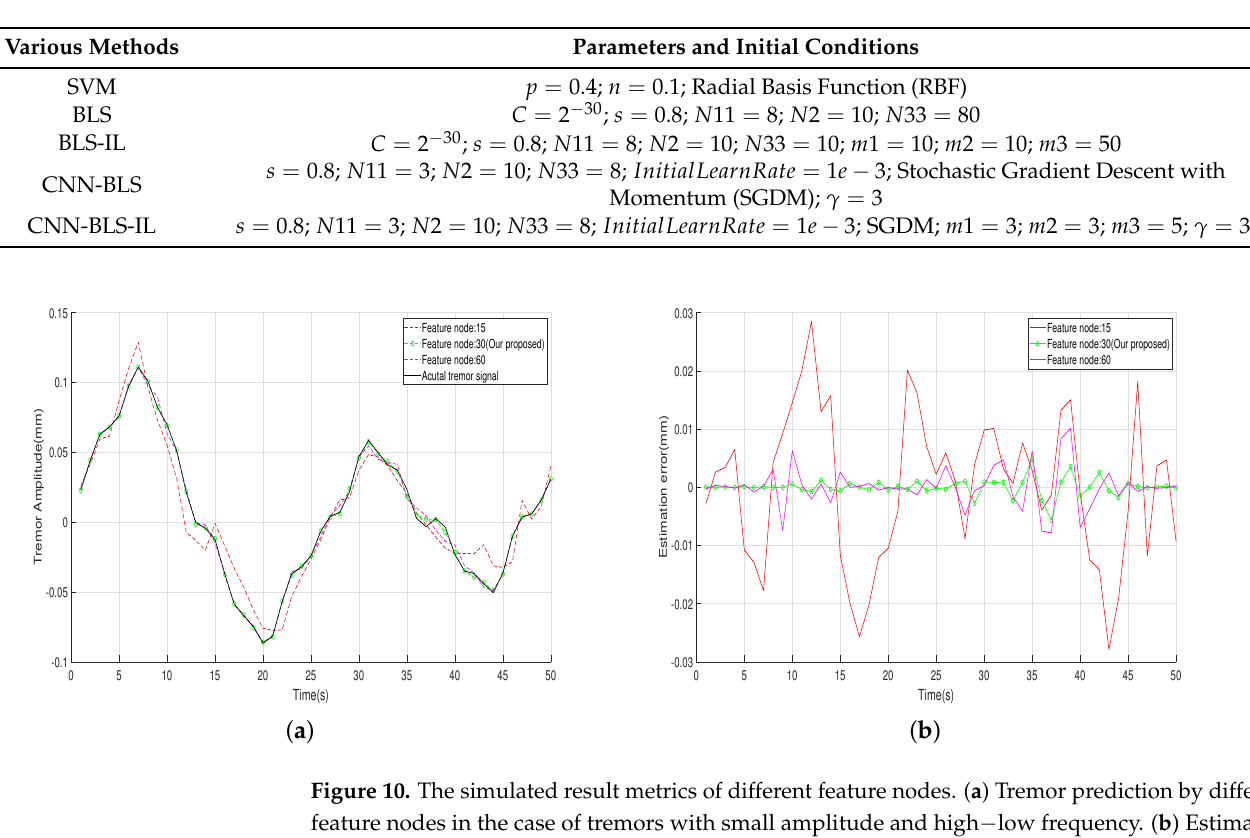
Table 2. Parameters and initial conditions of various methods.